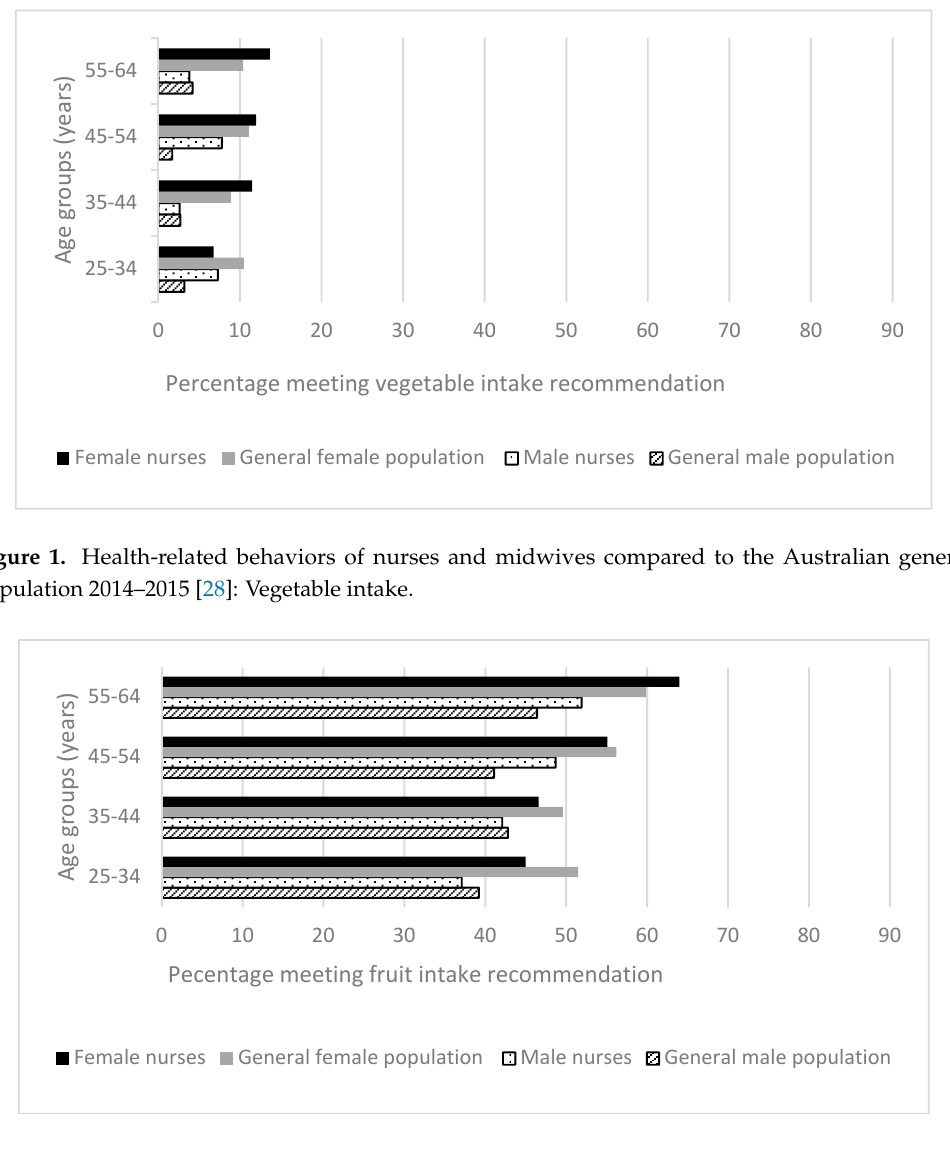
Figure 2. Health-related behaviors of nurses and midwives compared to the Australian general population 2014–2015 [28]: Fruit